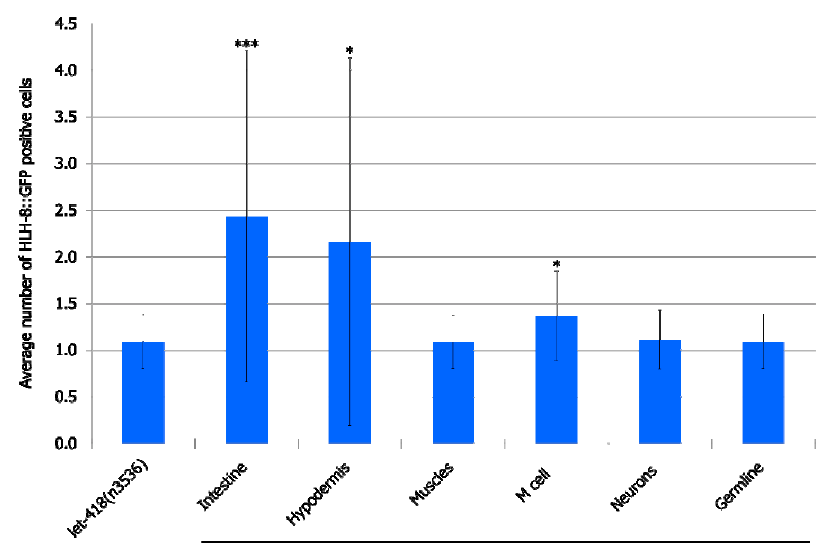
Figure 2. let-418 expression in the intestine and the hypodermis triggers postembryonic development of let-418 mutant. ( A ) The percentage of worms that showed >2 M cell divisions 30 h after birth is plotted for the different genetic backgrounds. ( B ) The average of GFP-positive cells 30 h after egg-laying is represented. * p < 0.05, *** p < 0.001; unpaired t -test against let-418(n3536) . For a better visual representation of the data the average number of M-cell descendant in wild type worm (18.7 ± 0.9) is not represented in the graph.